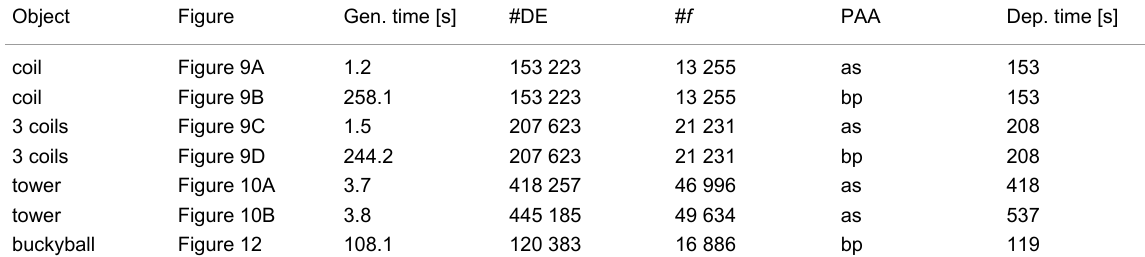
Table 1: Execution time of the pattern generator for selected examples of generated pattern files. All pattern files were generated using parameter settings for the Pt precursor. #DE specifies the total number of deposition events of the pattern file, # f the total number of frames and PAA the angle sorted (as) or best permutation (bp) proximity avoiding algorithm. Note that the single coils from Figure 9A and B are two times larger in x -, 2.5 times larger in y - and roughly two times larger in z -direction than each coil of the 3-layered coils from Figure 9C and D. Although Figure 9B has less DEs and frames than Figure 9D, the computation time for B was longer due to an approximately 18% higher number of DEs per frame in B than D (the higher coils in D have less turns). More DEs per frame make the bpPAA slower, since the number of possible permutations is larger. For the genera- tion of the buckyball a smaller n survivors was used than for the coils which results in a shorter execution